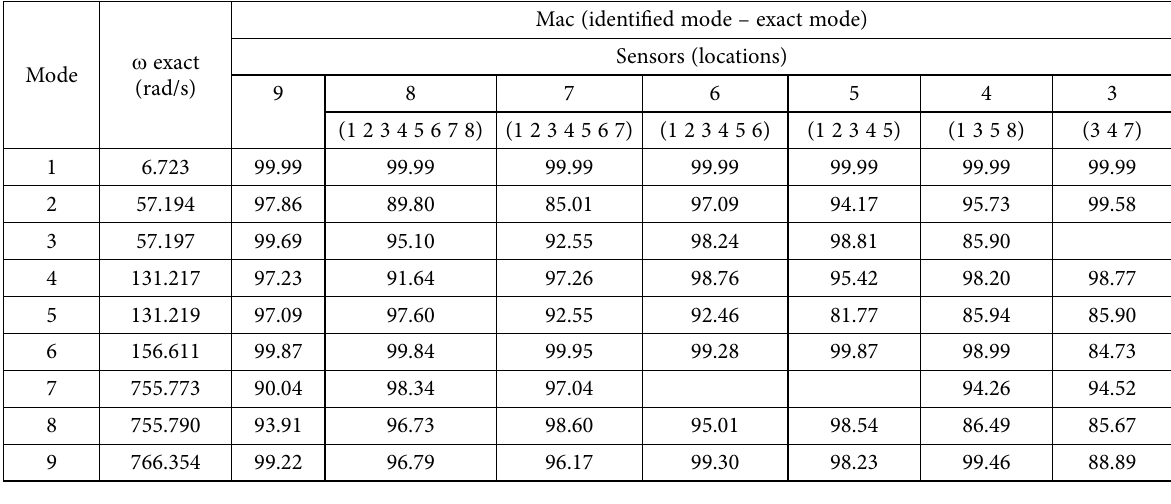
Table 4. MAC between the exact and identified mode shapes of the tripod simplex structure